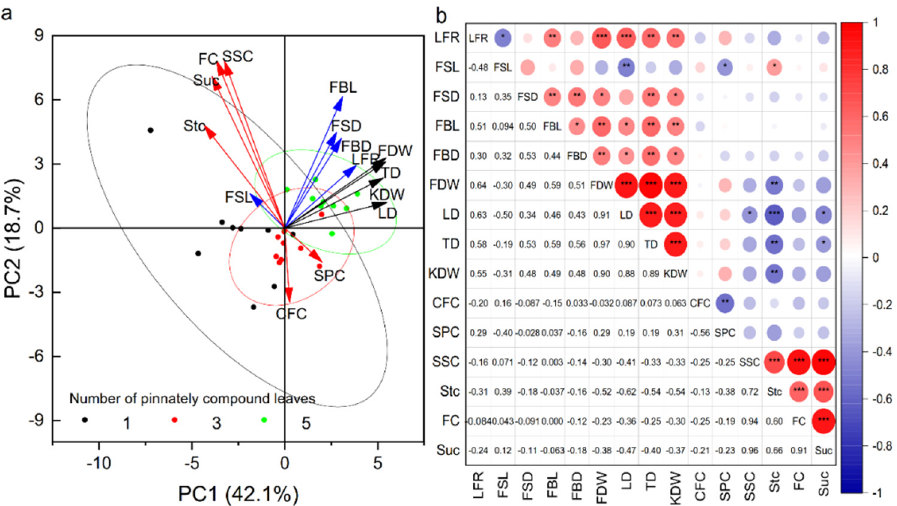
Figure 3. Fruit quality is associated with the agronomic traits of fruit-bearing branches. ( a ) PCA shows the distribution of agronomic traits and fruit quality indicators for different leaf − to − fruit ra- tios. ( b ) Heatmap of Pearson correlation coefficients between branch traits and fruit quality